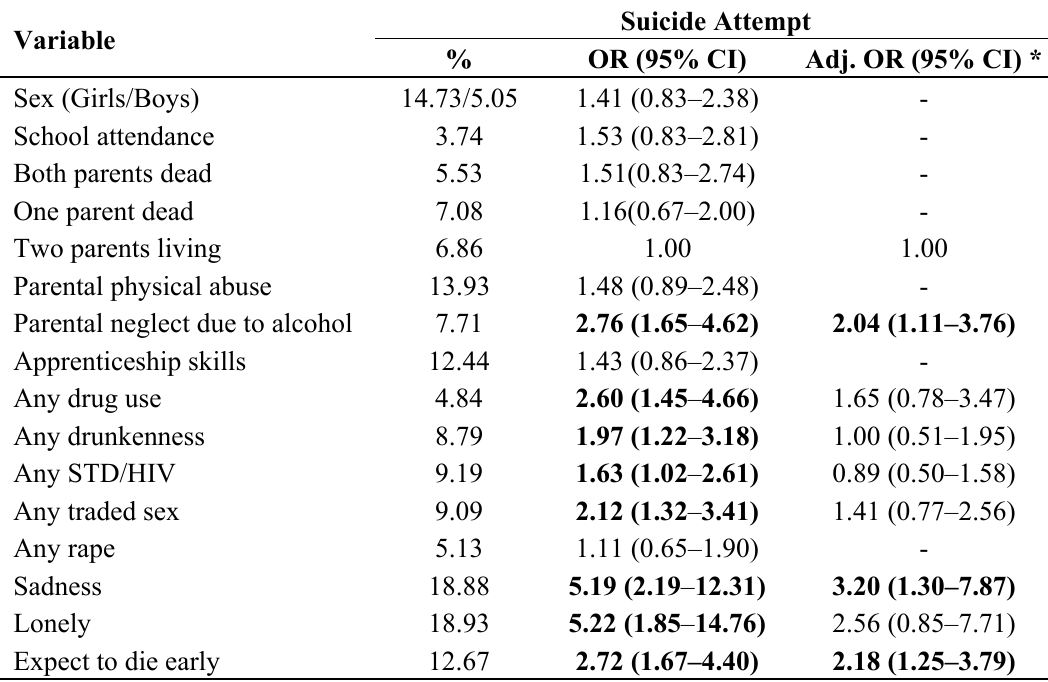
Table 3. Bivariate and multivariate associations between suicidal attempt and demographic characteristics, family context and psychosocial correlates among youth living in the slums of Kampala ( N =